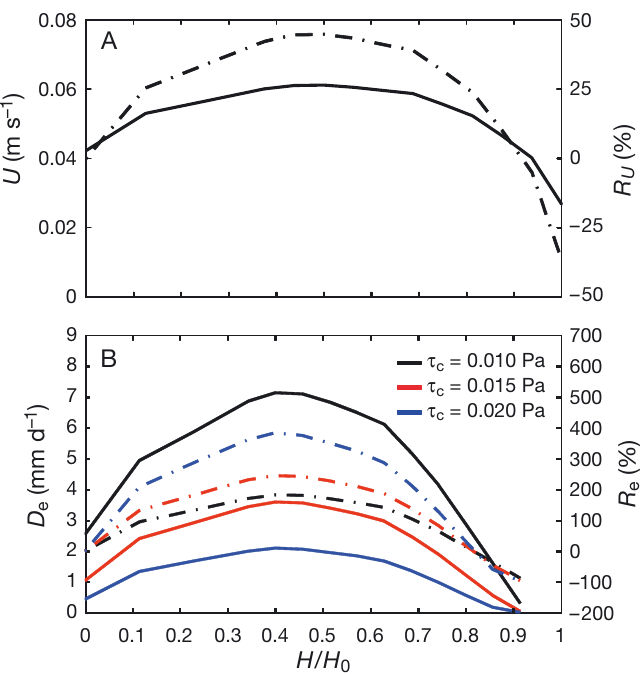
Fig. 9. (A) Bottom speed ( U) and (B) erosion rate ( D e ) versus cage height. Solid line: bottom speed/erosion (scale on left); dashed line: relative ratio ( R U and R e ) (scale on right). H indicates the cage height and H 0 indicates the mean water